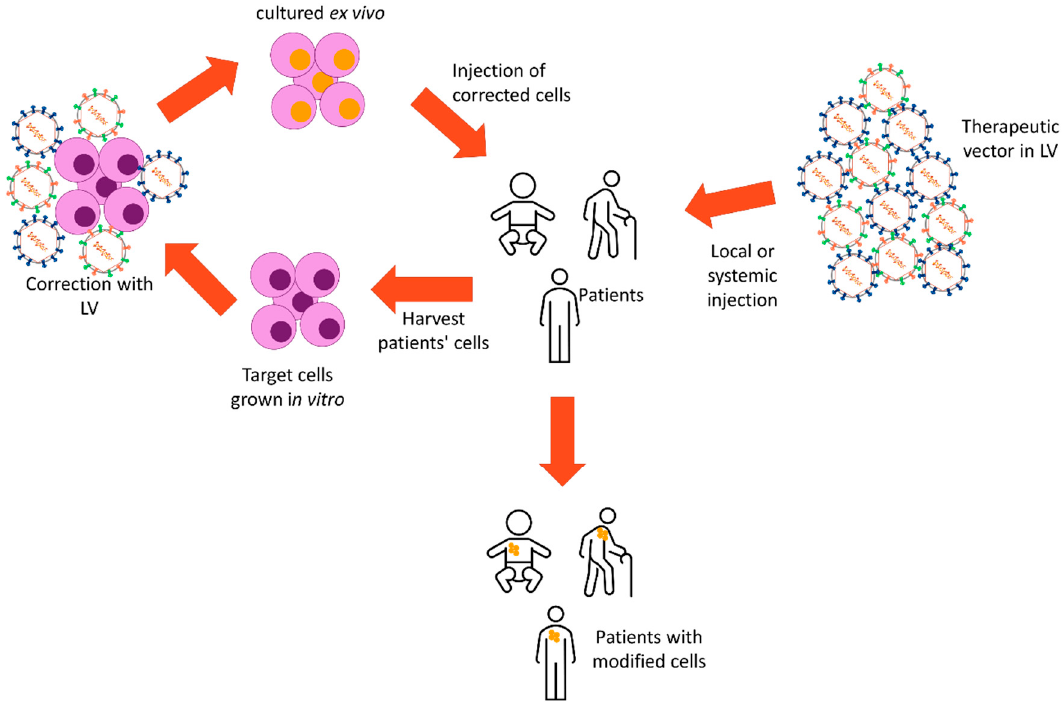
Figure 3. Gene therapy in vitro and in vivo. Cells from patients are harvested and cultured and modified with lentiviral vectors (LV) in vitro carrying a therapeutic vector. The corrected cells are then injected back into the patient for engraftment in order to alleviate the disease. The therapeutic vector can also be injected locally or systemically into the patients which will then transduce the target cells in vivo and correct the